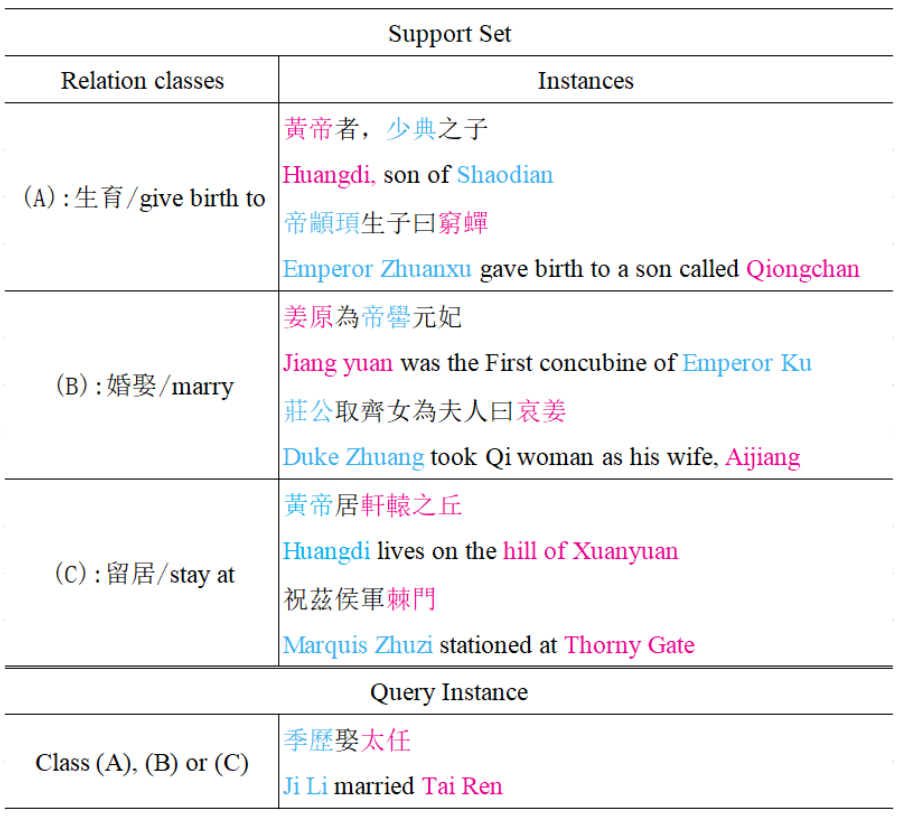
Figure 3. Samples for TinyACD-RC dataset, which has same structure with Table 1. For query instance, where Ji Li married Tai Ren, and because the word married, Ji Li should have a marital relation with Tai